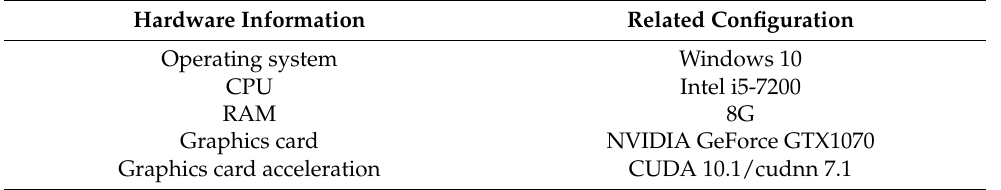
Table 2. Experimental platform